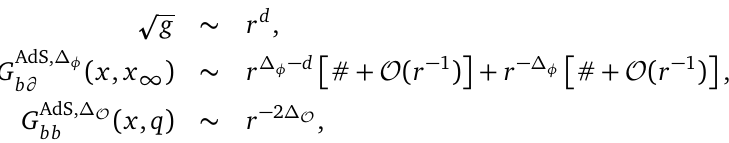
Figure 1: Bulk dual of the thermal one-point function as a sum over bulk diagrams. Here, the blue line represents the thermal AdS bulk-to-boundary propagator G In the first diagram, the red line winding around the thermal circle once represents ∆ O the G AdS , contribution, while in the second diagram, the red line winding around bb the thermal circle twice represents the contribution from two windings around the thermal circle. The bulk point x is to be integrated over all thermal